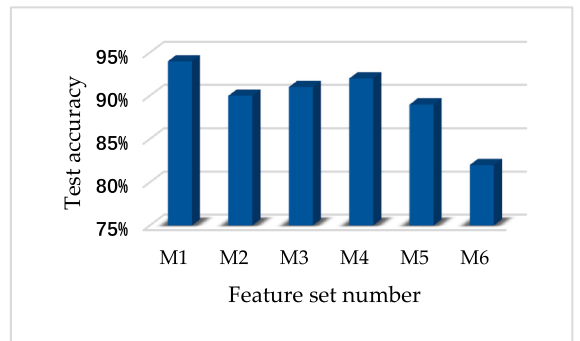
Figure 8. Support vector machine (SVM) test ‐ classification results of six different feature sets in experiment data 1.